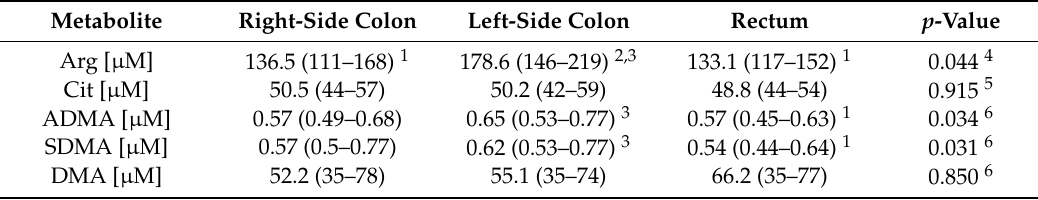
Table 5. Association between L-arginine/NO pathway metabolites and the sublocation of a primary Association between L-arginine / NO pathway metabolites and the sublocation of a tumor. primary